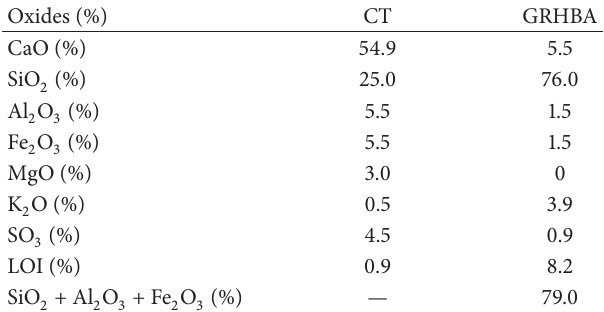
Table 2: Chemical components of CT and pozzolanic materials [4].